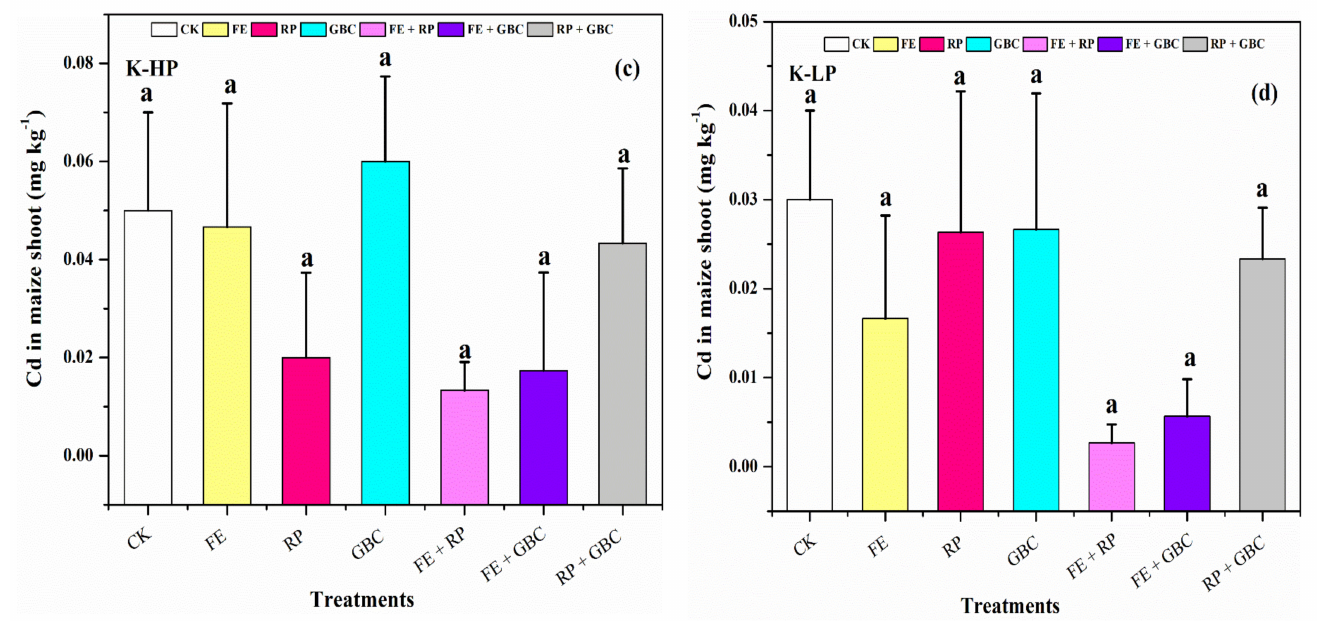
Figure 8. Influence of additives on Fe in ( a ) in K-HP maize shoot and ( b ) H-LP maize shoot; influence of additives on Cd in ( c ) K-HP maize shoot and ( d ) in H-LP maize shoot. The values in a given column followed by the same letter are statistically not significantly ( p < 0.05) using Tukey’s HSD